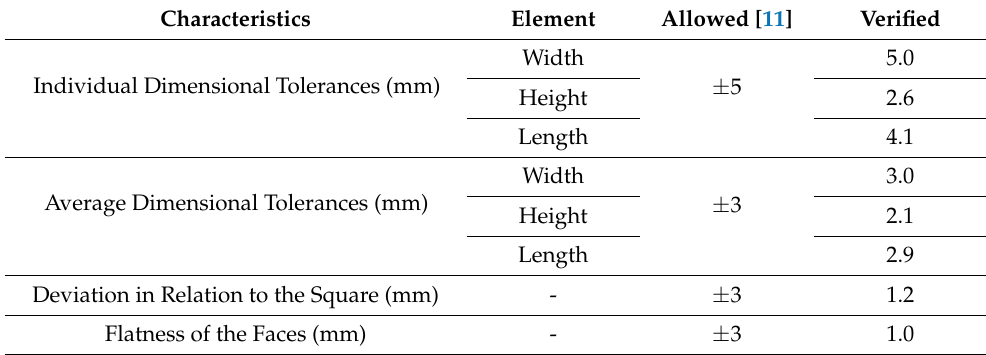
Table 1. Geometrical characteristics.